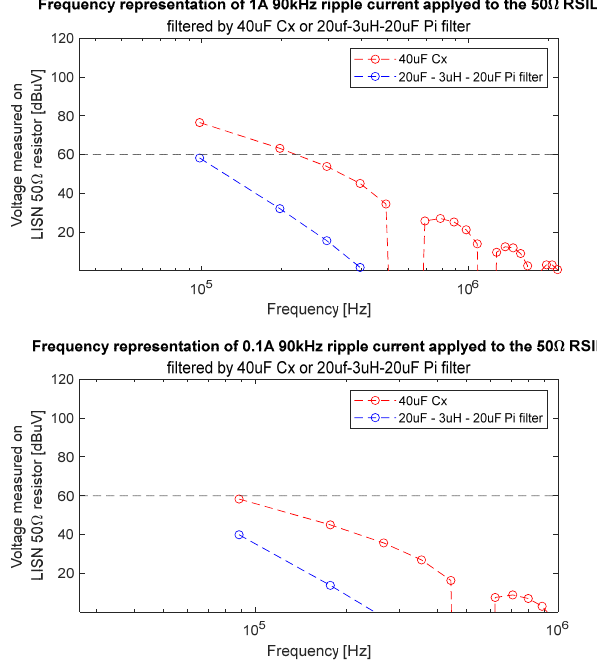
Figure 13. Frequency domain representation of 1A magnitude at 83% duty cycle filtered by a Cx capacitor of 40 µ F or by a C x 1 − L − C x 2 filter ( C x 1 = 20 µ F, L = 3 µ H, C x 2 = 20 µ F) to meet the 60 dB µ V limits using Equation (15) to calculate the value of L .